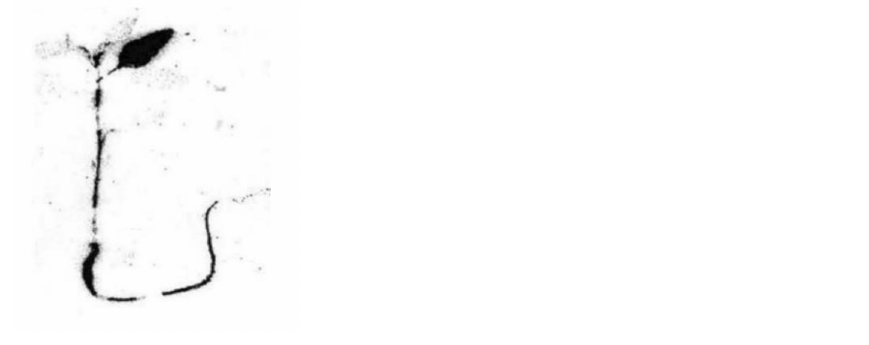
Figure 6. Autoradiography of the shoots Sinapis arvensis L., 32 h after the treatment [44]. The accumulation of radiocarbon in the plant tissues is dark colored in Figures 5 and